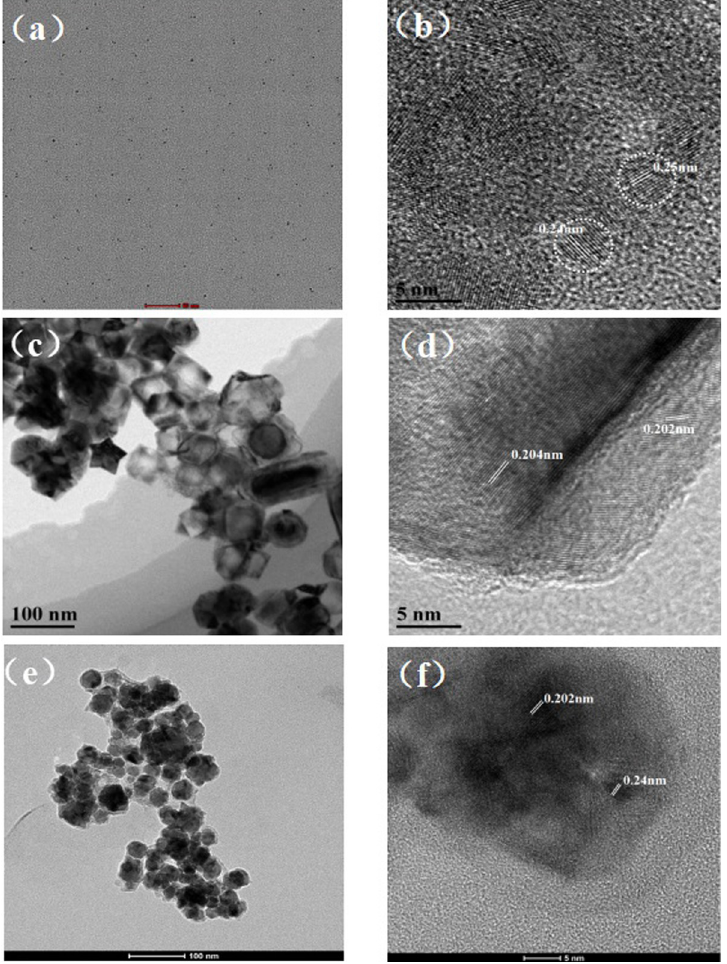
Fig 1. TEM and HRTEM images of N-GQDs, Cu@Ni CSNPs and Cu@Ni CSNPs/N-GQDs NCs. TEM image ( a ) and HRTEM image ( b ) of N-GQDs; TEM image ( c ) and HRTEM image ( d ) of Cu@Ni CSNPs; TEM image ( e ) and HRTEM image ( f ) of Cu@Ni CSNPs/N-GQDs NCs.